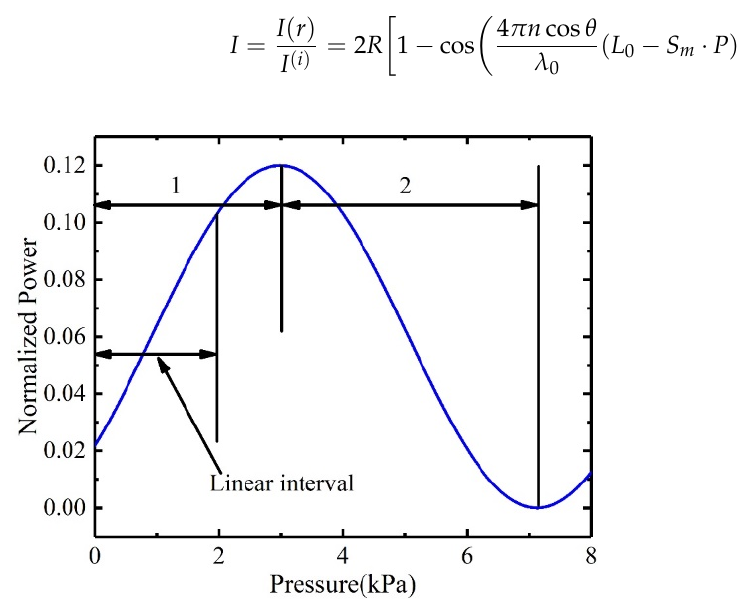
where L 0 is the initial cavity length of the FP cavity.